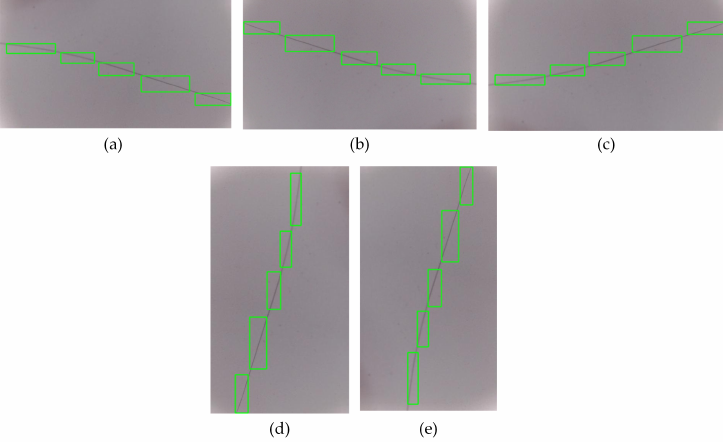
Figure 8. Data enhancement. ( a ) The original image, ( b ) rotated 180 ◦ counterclockwise, ( c ) flipped horizontally, ( d ) rotated 90 ◦ counterclockwise, ( e ) rotated 270 ◦ counterclockwise.